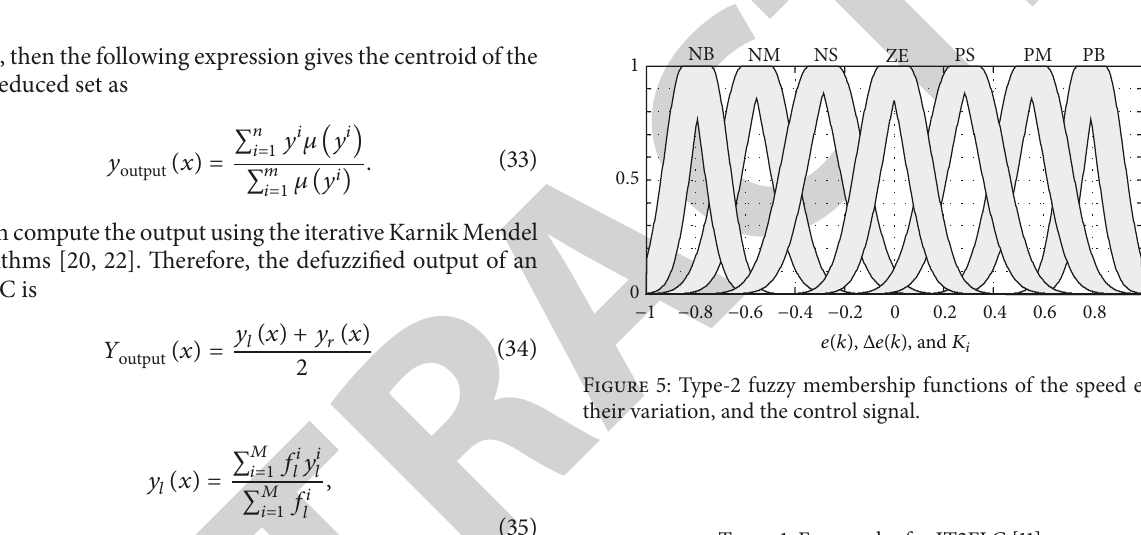
Table 1: Fuzzy rules for IT2FLC